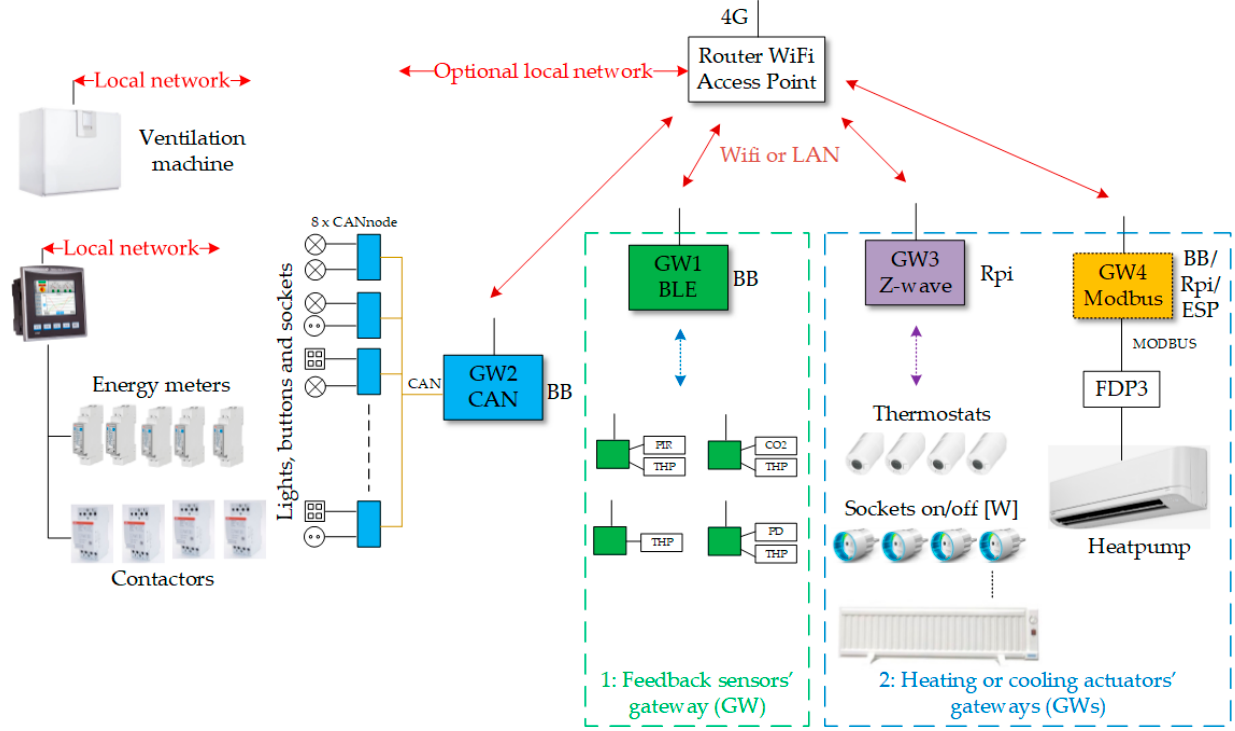
Figure 2. The overall setup and interconnections of hardware and software components (this gateway is GW3 in Figure 3).